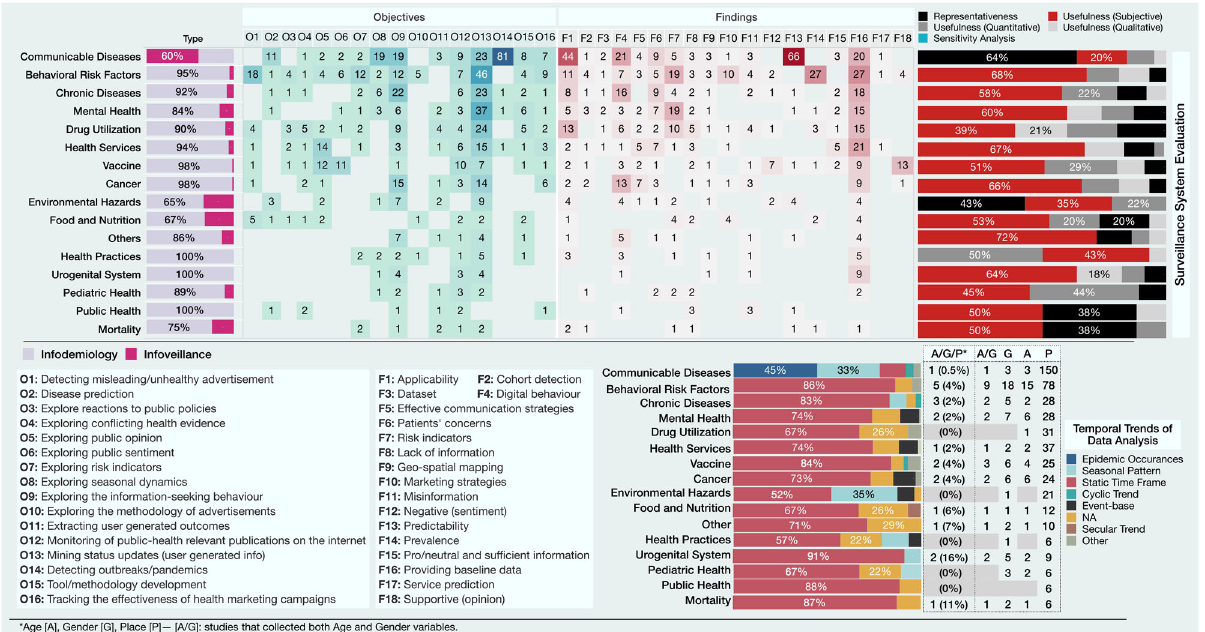
Fig. 6 The top charts illustrate the mapping between PHS topics and objectives [O], and fi ndings [F] of their corresponding studies, the frequency of infoveillance/infodemiology studies for each topic, and the techniques used by the included publications to evaluate the effectiveness of their proposed approach in addressing the key objectives of a surveillance system. The bottom charts represent the temporal trends of data analysis used by the included studies and the frequency of articles that identi fi ed each of the age/gender/place in their